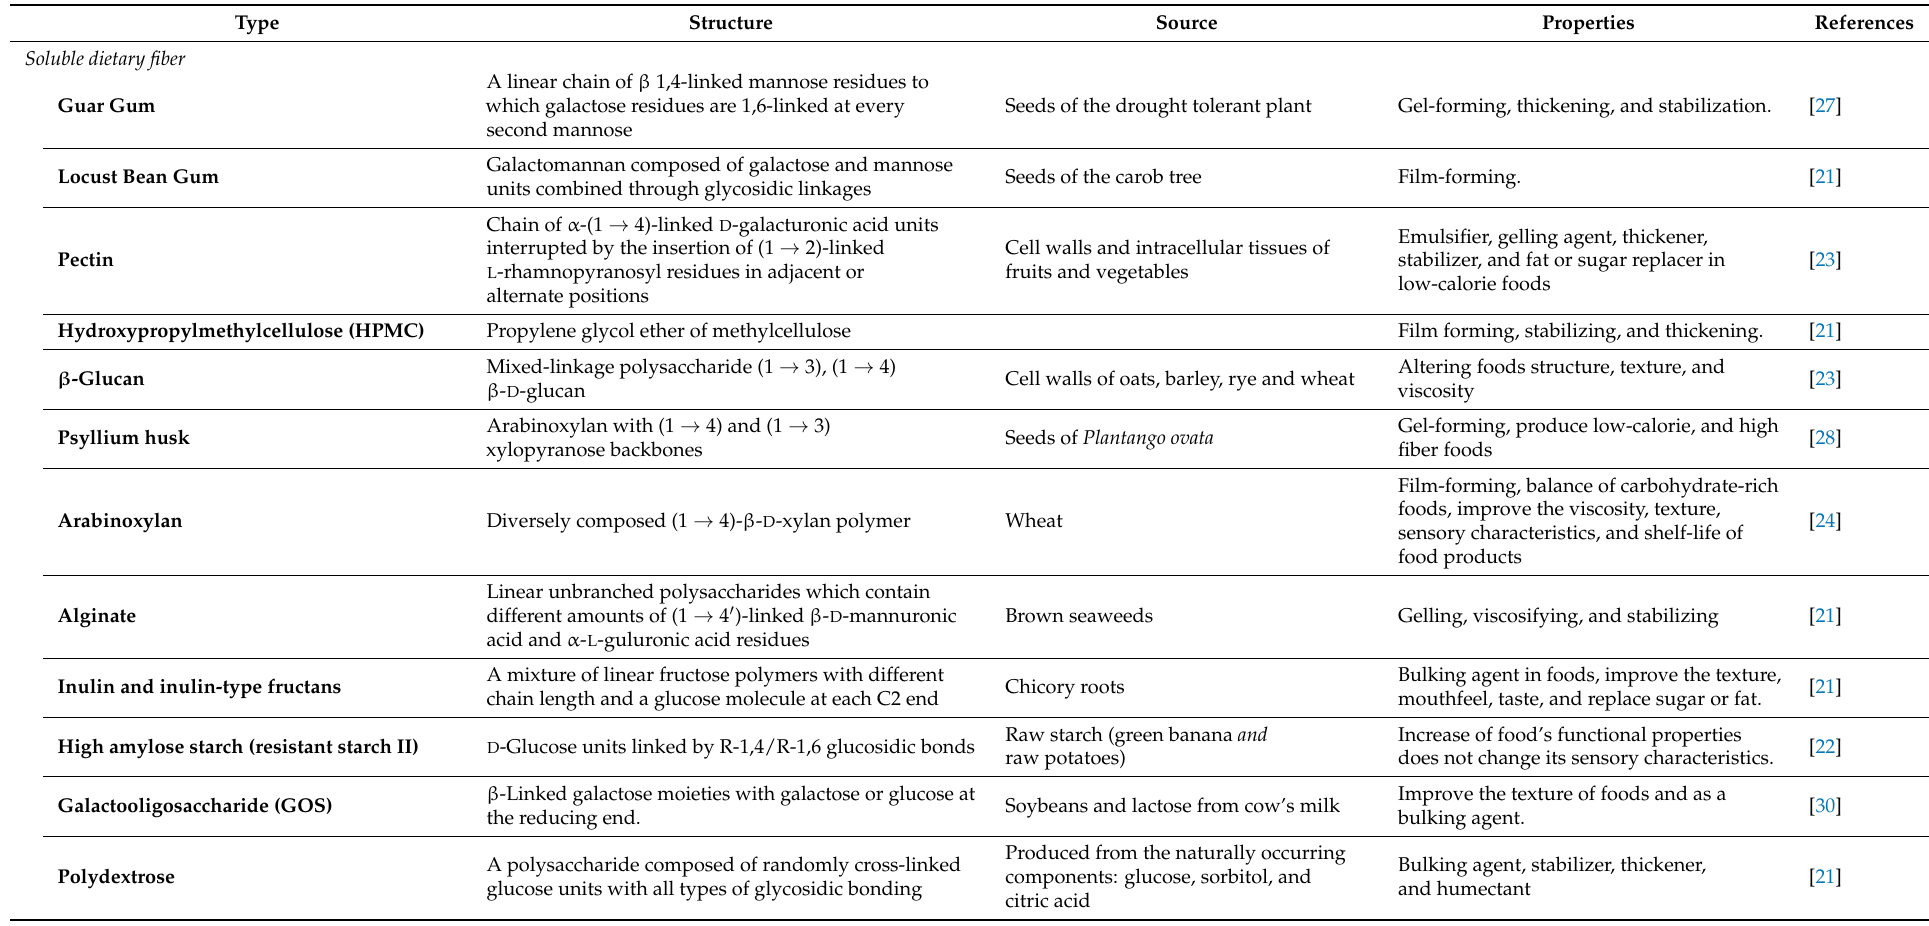
Table 1. Types of NDCs and their